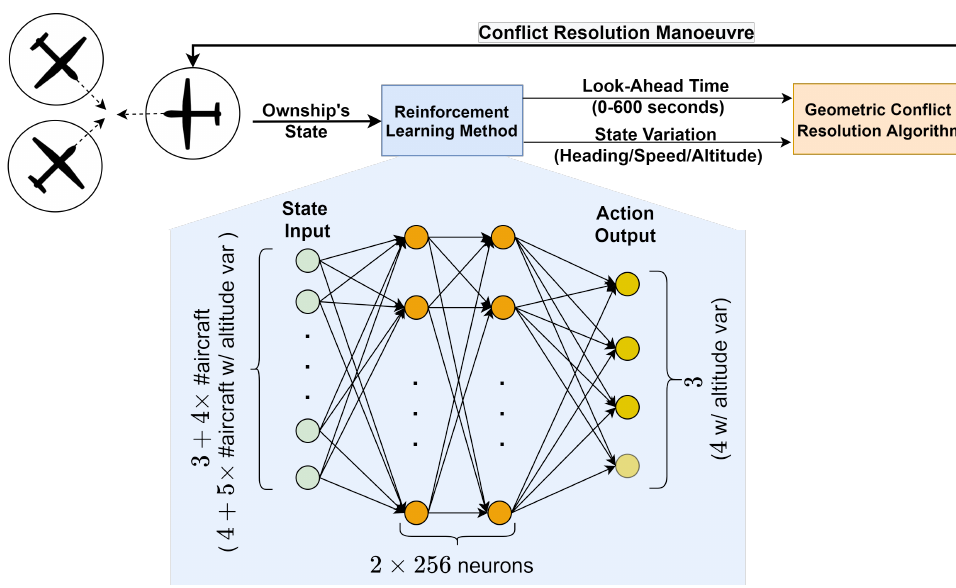
Figure 1. A high-level representation of the hybrid CR system implemented in this work. Based on the ownship’s current state and closest surrounding aircraft, the RL method makes a decision on look-ahead time and in which way the state of the ownship will vary. The geometric CR algorithm then uses these values to generate the CR manoeuvre. The size of the state and action formulations vary depending on whether the geometric CR method performs altitude variation on top of heading and speed